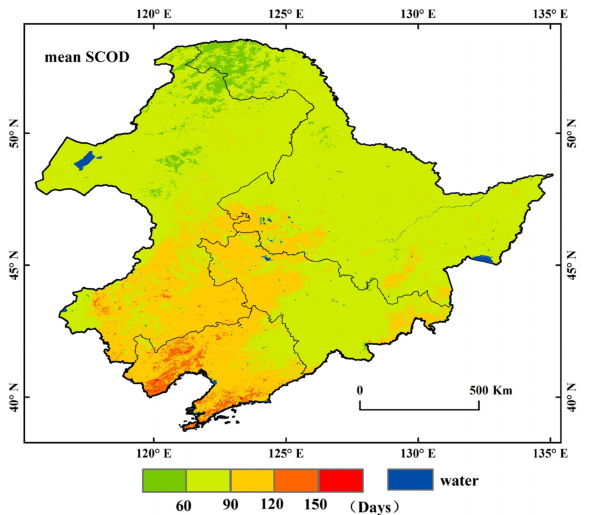
Figure 6. Spatial distribution of annual average SCOD in Northeast China from HY2001 to